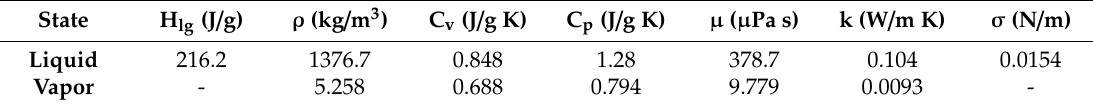
Table 1. Saturation properties of R134a at atmospheric pressure ( − 26.07 ◦ C), from the NIST Chemical Webbook Database